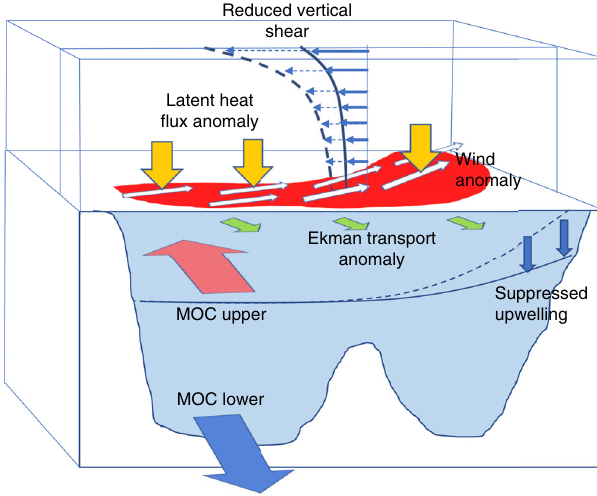
Fig. 6 Schematic of the mechanisms which contributed to the positive SSTA in the MDR, and an active hurricane season, in 2017. Orange arrows are the heat exchange anomalies. White arrows show the wind driven anomalies forcing the ocean. The green arrows show the wind driven Ekman transport anomaly response. The blue line indicates the notional surface temperature with suppressed upwelling (solid line) and without suppressed upwelling (dashed